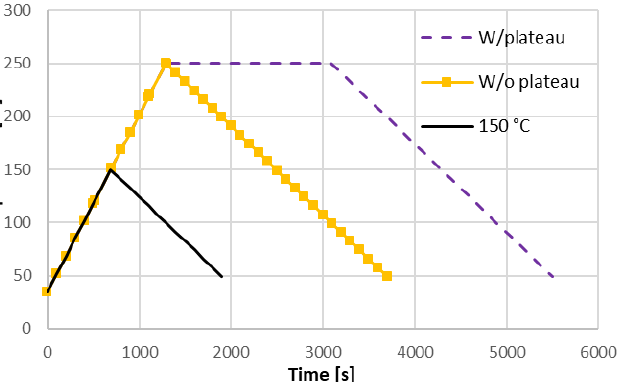
Figure 1. Temperature profile considered for annealing the samples and measuring the warpage in